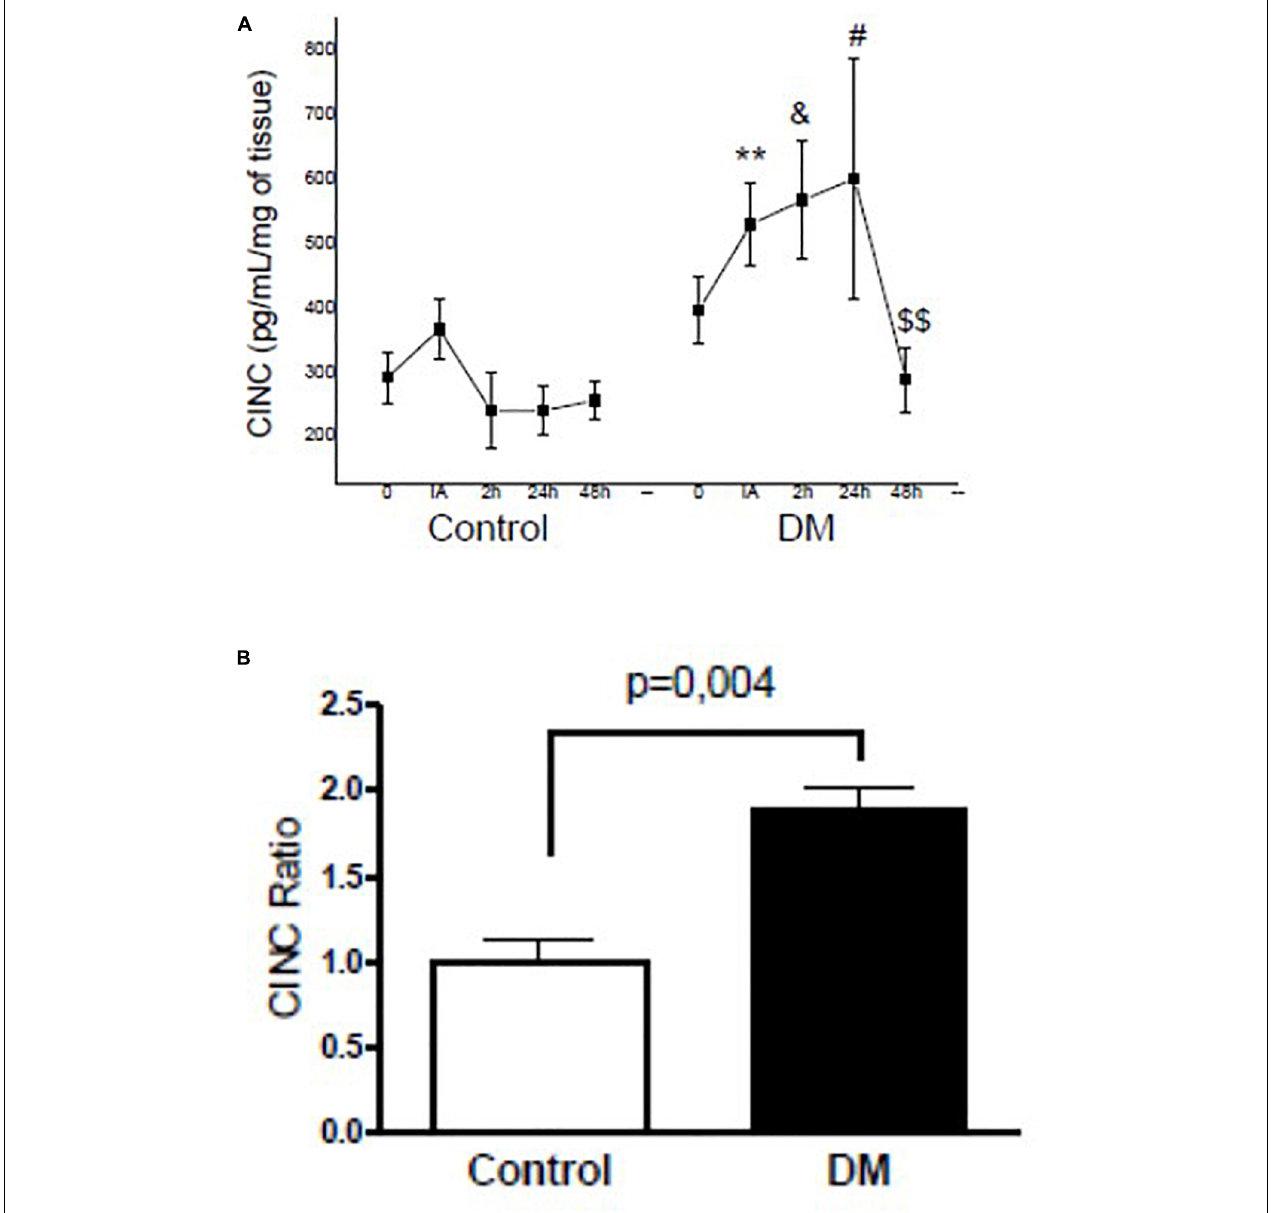
FIGURE 2 | (A) Kinetic profiles of the cytokine-induced neutrophil chemo-attractants (CINC) concentration in the skeletal muscle of the control and diabetic animals assessed before (0), immediately after (IA), and at 2 h (2), 24 h (24), and 48 h (48) after exercise. (B) CINC ratio of the IAUC between the control and diabetic rats. The values represent the means ± SE of seven animals per group. ** < 0.05 versus IA (control); & < 0.05 versus 2 h (control); # < 0.05 versus 24 h (control); $$ < 0.05 versus 24 h